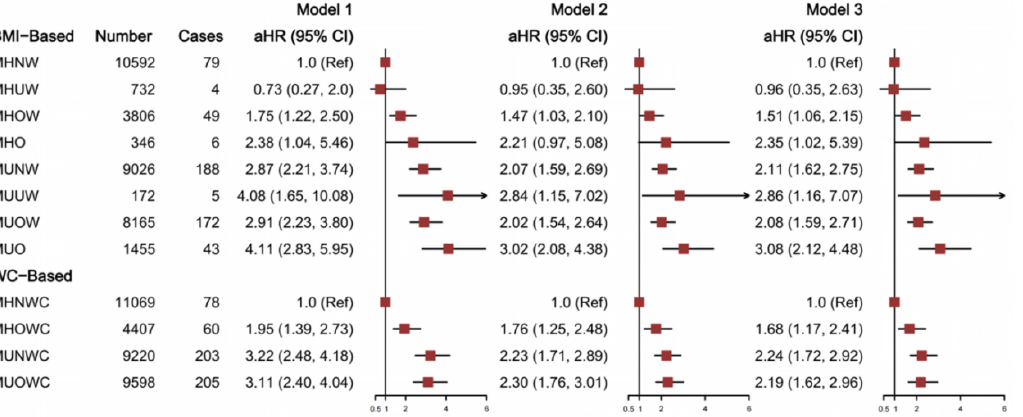
Table 3. Association between the number of metabolic abnormalities and risk of stroke in different BMI and WC groups. Variables